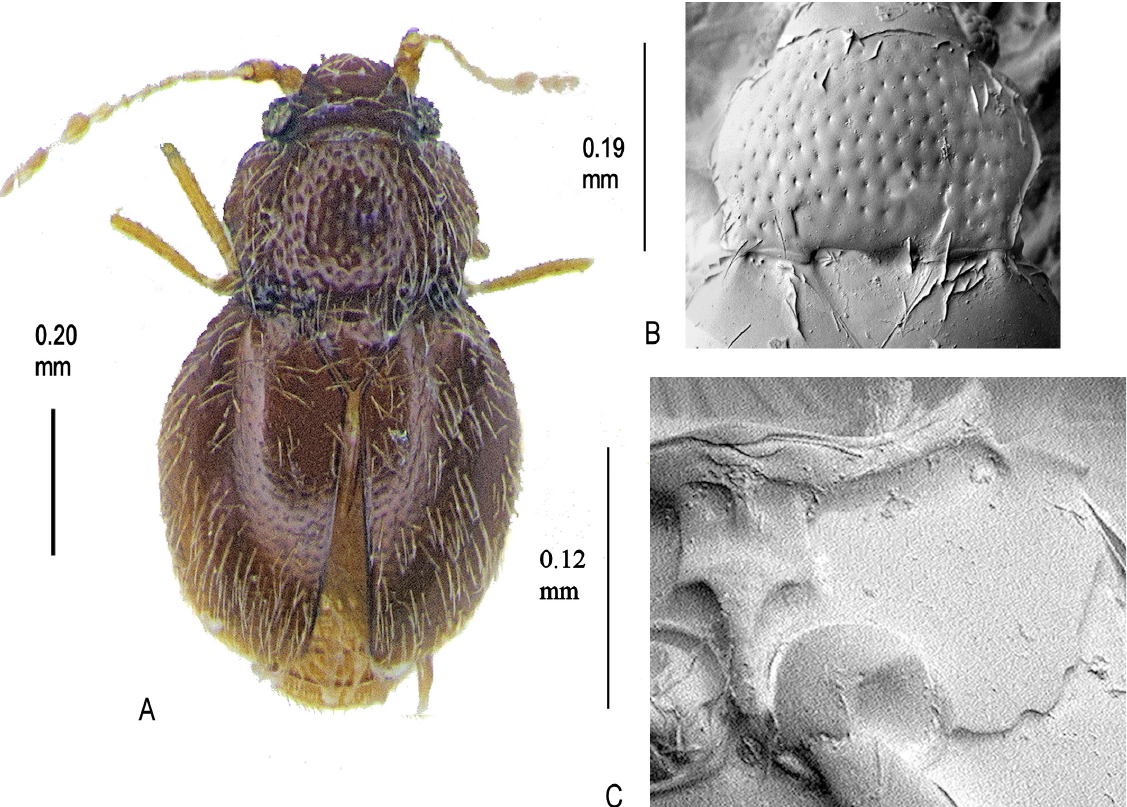
Fig. 49 . Cissidium globulum Darby, 2019. A . Habitus. B . Pronotum, × 450. C . Mesoventrite showing median process of collar, mid-keel, keel and lateral margin, ×